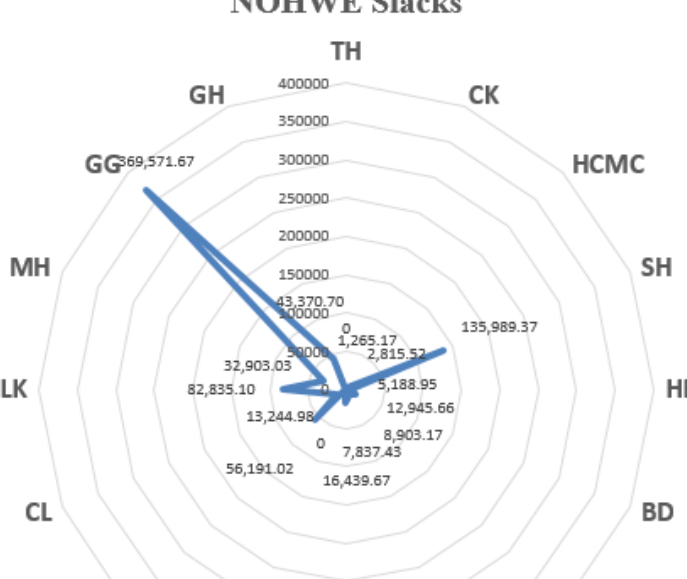
Figure 5. NOHWE Slacks.